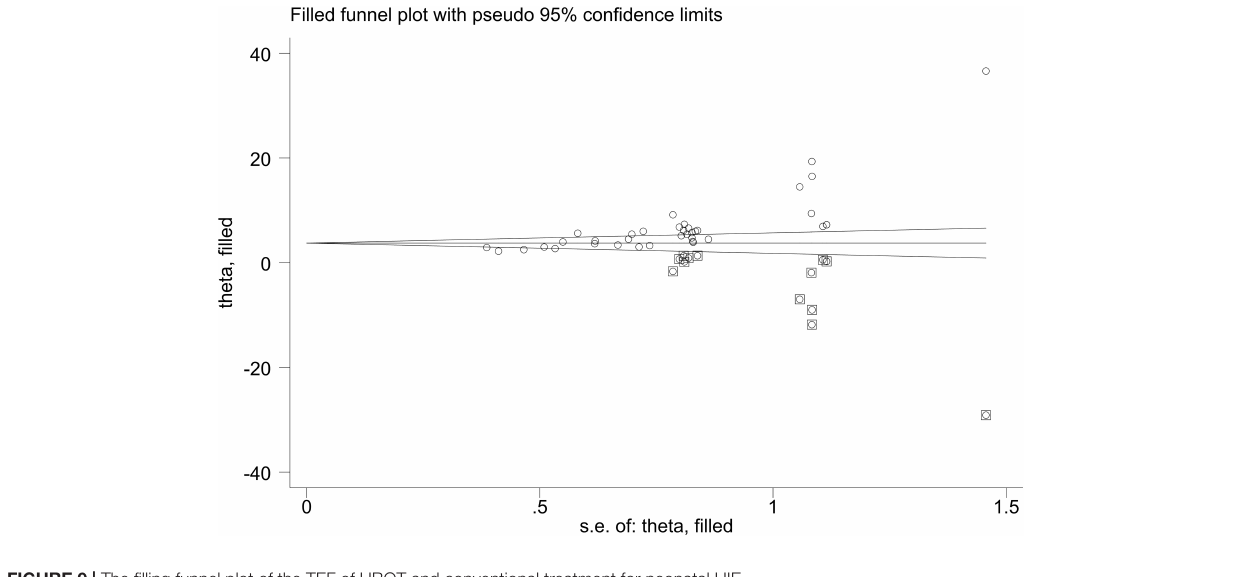
FIGURE 9 | The filling funnel plot of the TEF of HBOT and conventional treatment for neonatal HIE. TABLE 2 | Subgroup analysis of oxygen uptake, treatment duration, and HBOT pressure.